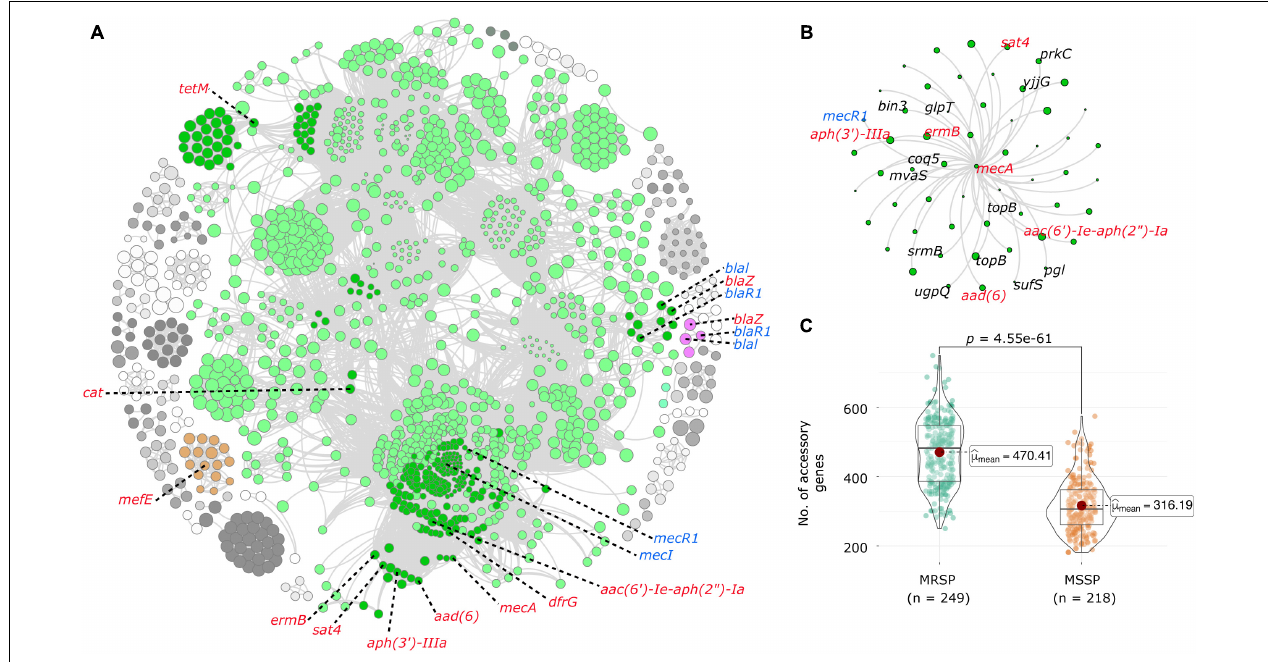
FIGURE 3 | Coincident accessory and resistance genes. (A) Network diagram created with Gephi using output from Coinfinder carried out on 467 S. pseudintermedius genomes. Coincident gene clusters containing resistance genes are represented in color. The dark green nodes in the large green cluster represent genes associated with resistance genes. Resistance genes are labeled in red, and regulatory genes in blue. (B) Close-up view of the network that contains the mecA gene. Other resistance genes are colored in red, and genes with known functions are labeled in black. All other genes are hypothetical proteins. (C) Violin plots comparing the number of accessory genes in MRSP and MSSP isolates, created with ggstatplot. Violin plots depict the minimum, first quartile, median, third quartile and maximum values, with data points shown. The difference in the number of accessory genes is highly significant ( p < 0.0001).